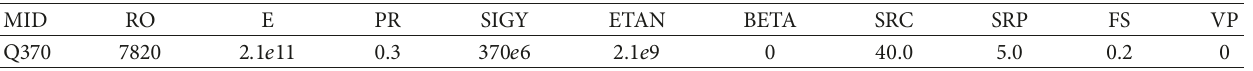
Table 2: The parameters of steel material model.